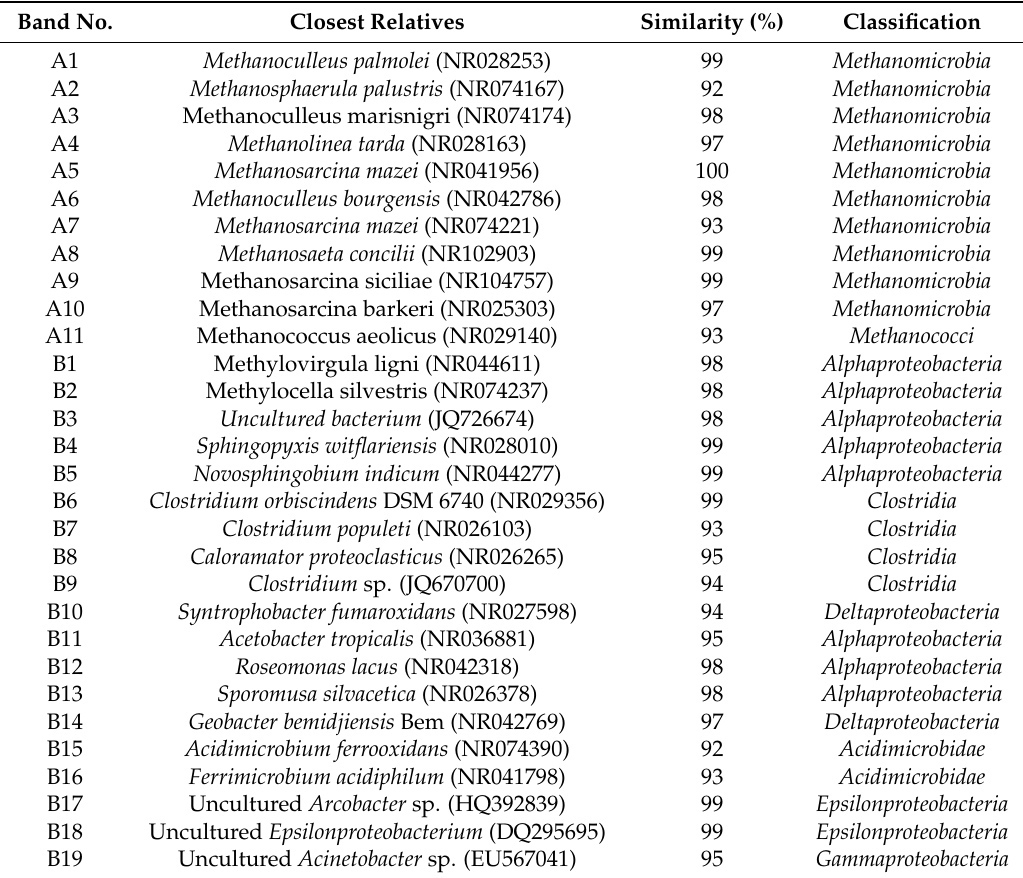
Table 5. Phylogenetic affiliation of archaeal and bacterial 16S rRNA gene sequences retrieved from DGGE bands. Band